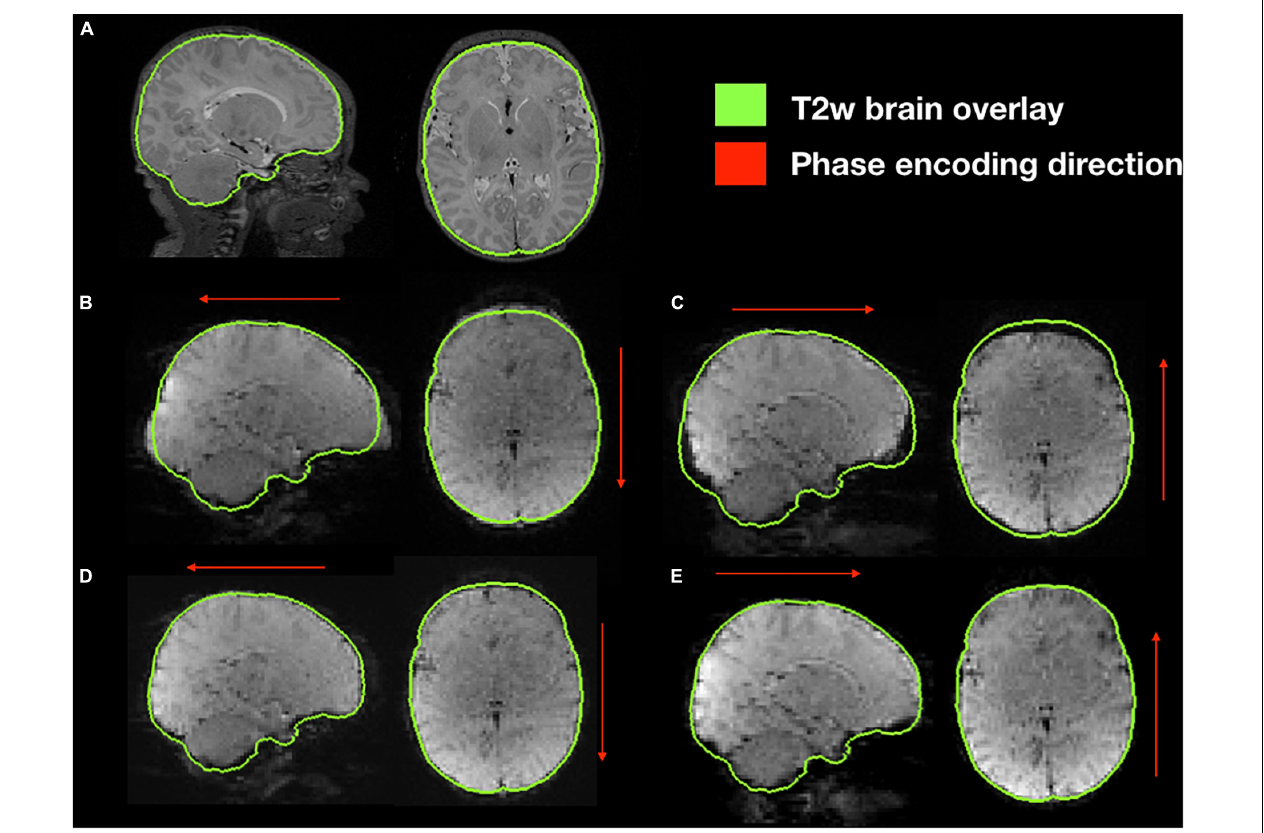
FIGURE 8 | Susceptibility-induced magnetic field inhomogeneity causing geometric distortions along the phase encoding direction. (A) Original T2-weighted image without distortion, shown as reference; (B) original GRE-EPI acquired in anterior-posterior phase encoding direction (AP); (C) original GRE-EPI acquired in posterior-anterior phase encoding direction (PA); (D) corrected GRE-EPI AP; (E) corrected GRE-EPI